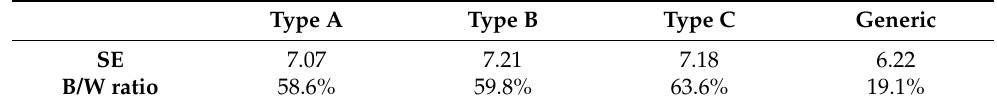
Table 2. Comparison between the Shannon entropy values and the black/white ratio of the analyzed foams, containing flame retardant graphite particles, and of a generic soft PU